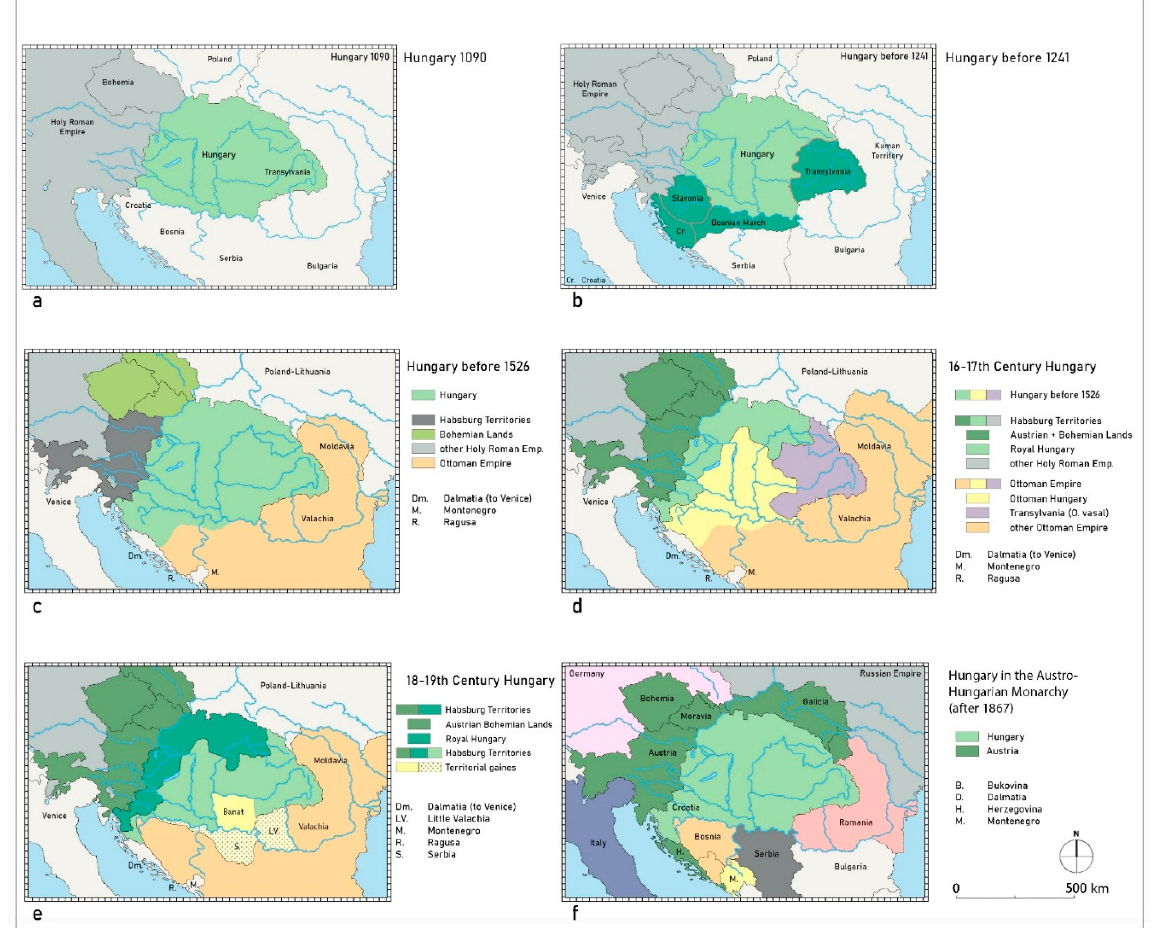
Figure 1. Graphical representation of the major historical periods of the Kingdom of Hungary.